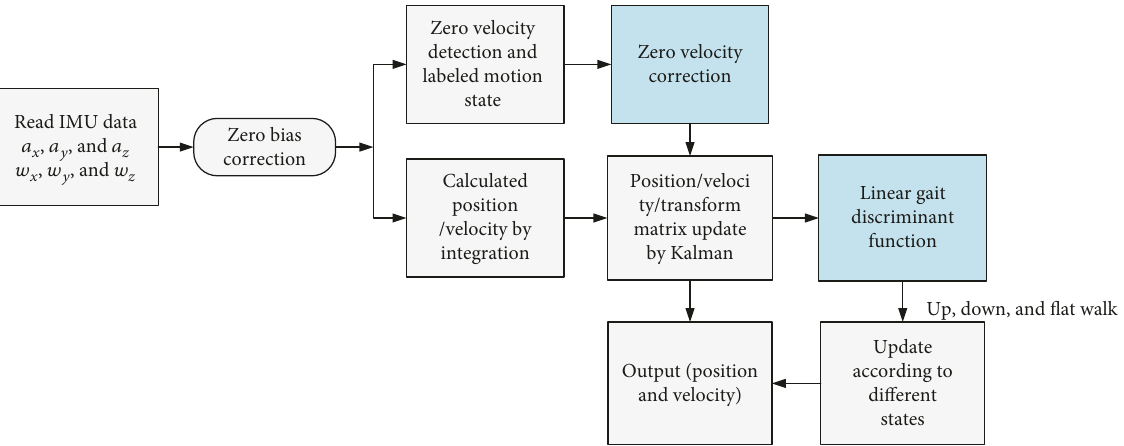
Figure 3: The algorithm architecture.